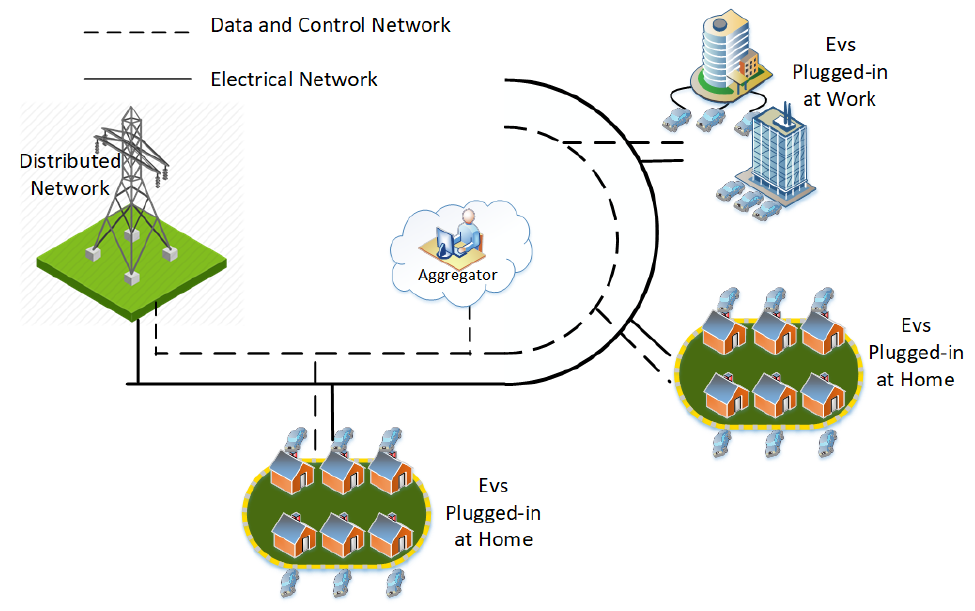
Figure 1. V2G system